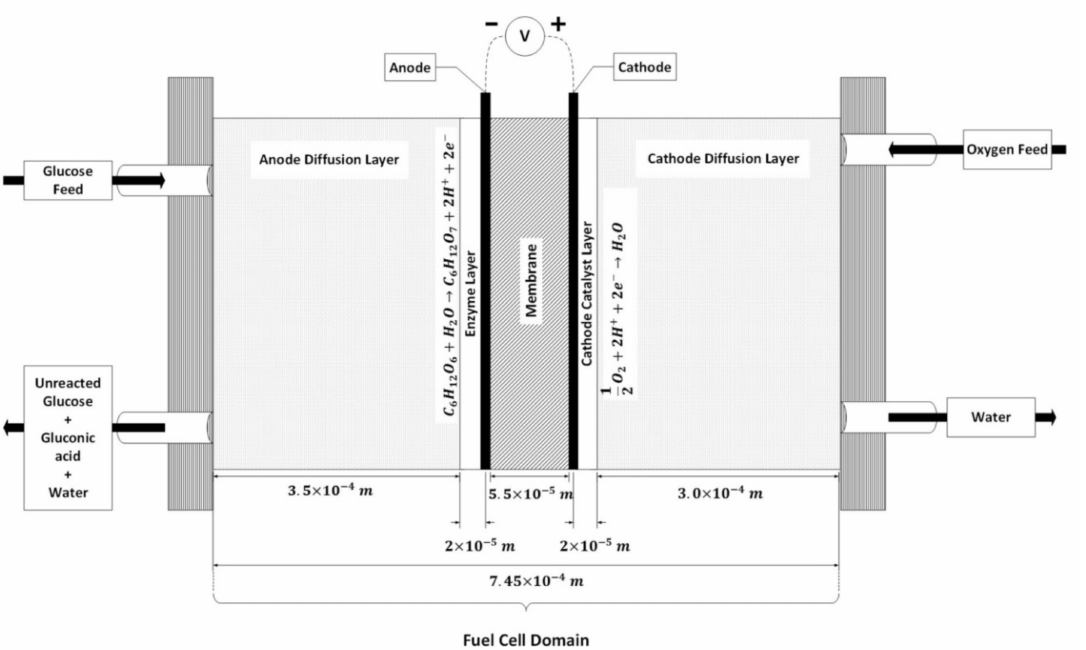
Figure 15. Schematic representation of the glucose enzymatic fuel cell used for the model reported in [51]. Reprinted from [51], with permission from